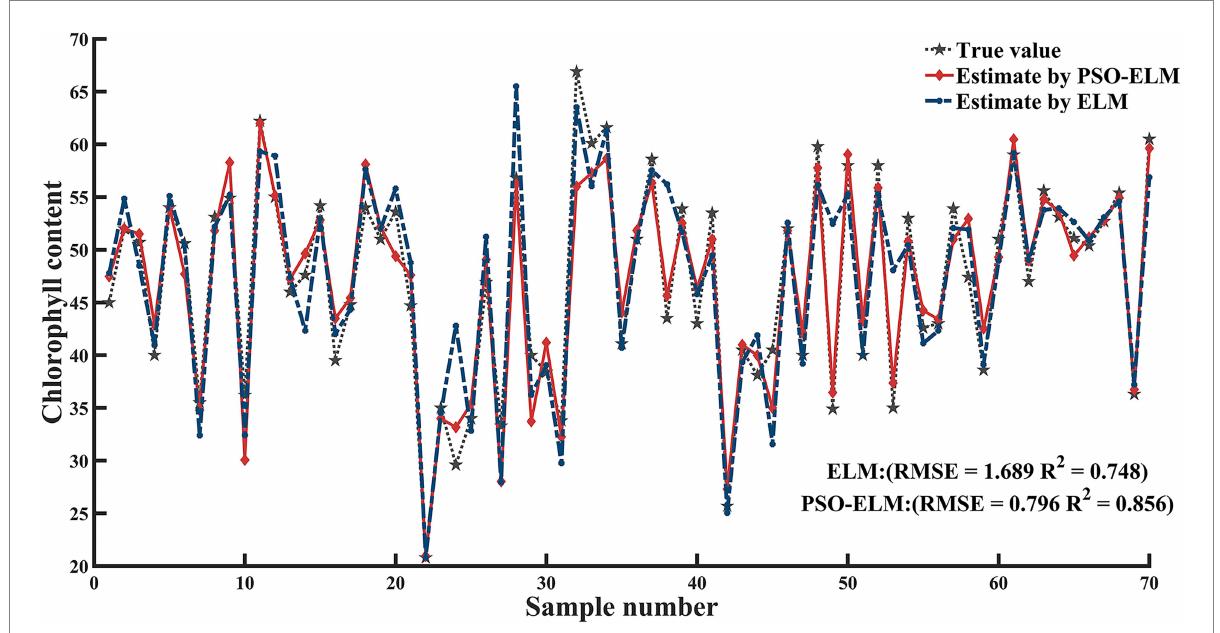
FIGURE 9 ELM and PSO-ELM models Chlorophyll content inversion model.